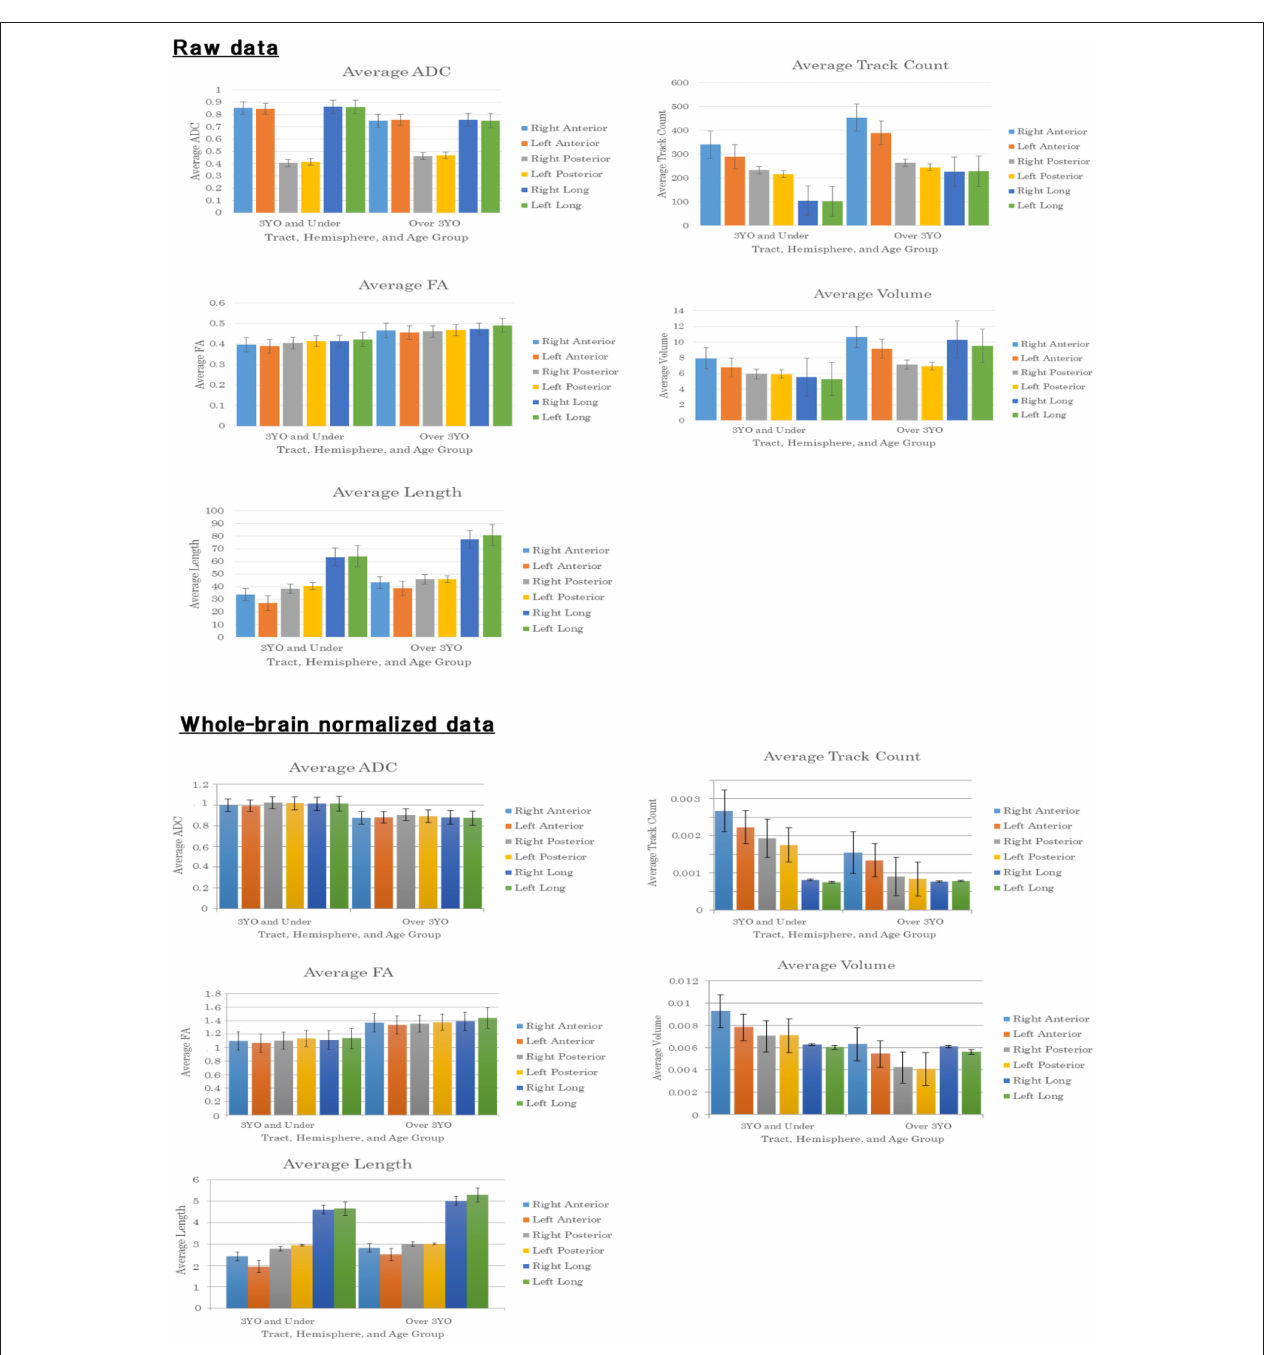
FIGURE 3 | Bar graphs of averaged values and standard deviations for each measure studied: ADC (mm 2 /s), volume (ml) and length (mm).